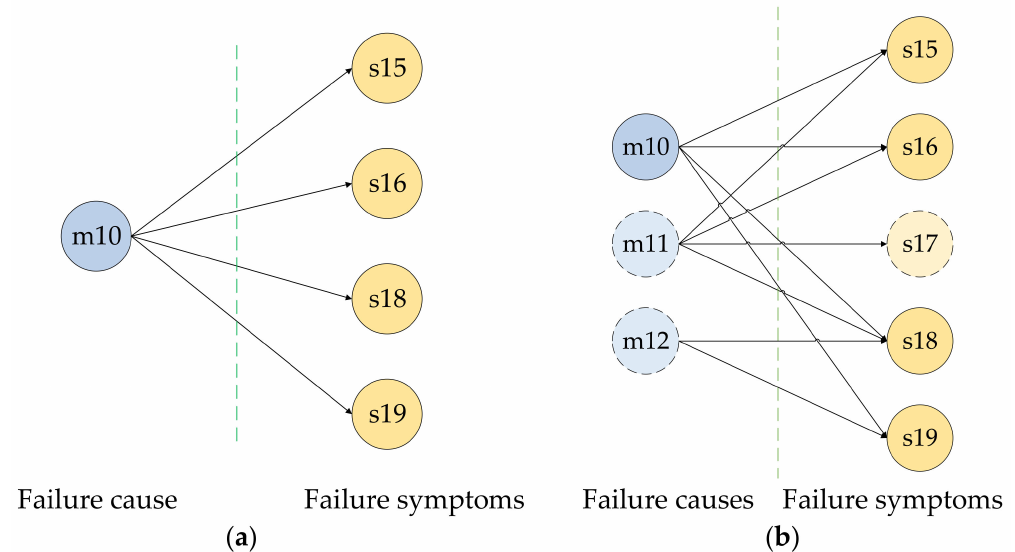
Figure 1. Schematic diagram of reasoning chain for relay protection device TV secondary circuit multipoint grounding fault